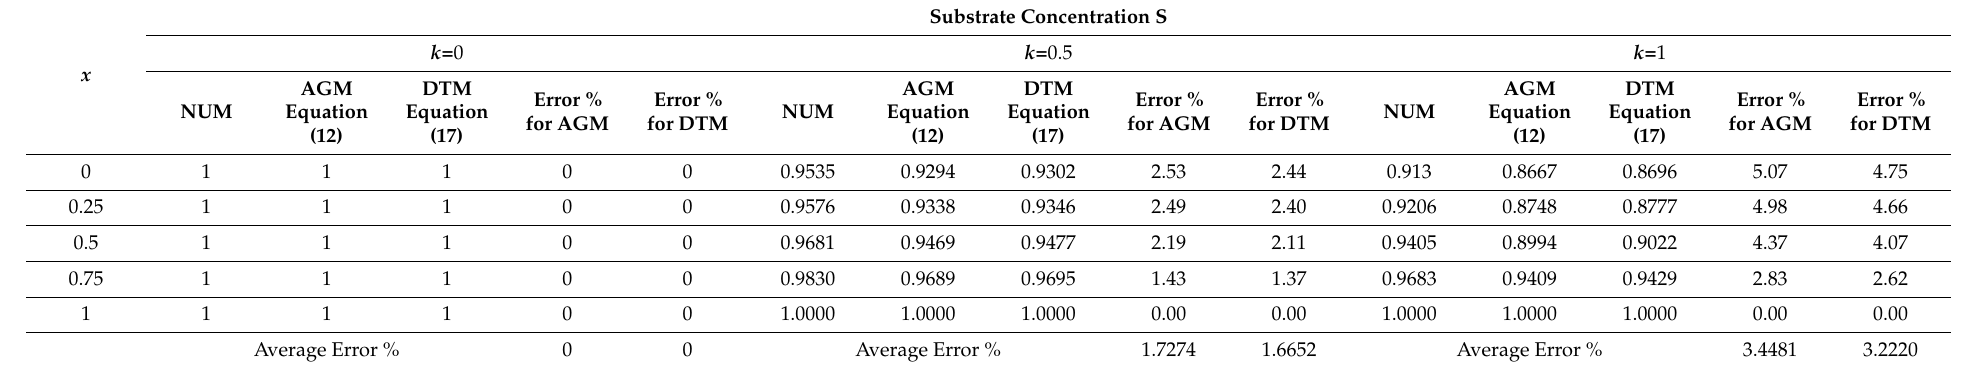
Table 1. Comparison between the numerical and analytical expression of the concentration of the substrate obtained by AGM and DTM for the parameters α = 0.8, γ = 0.5, and for different values of k .